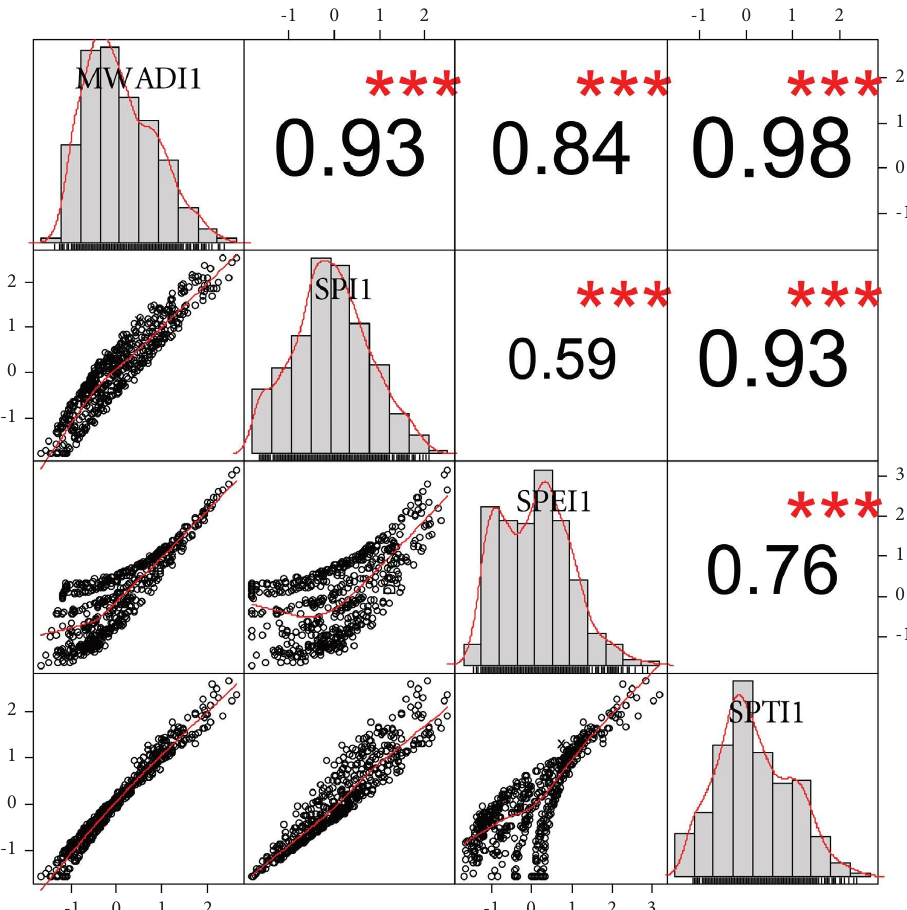
Figure 7: Te correlation chart of the MWADI with other SDIs (the SPI, the SPEI, and the SPTI) at the Astore